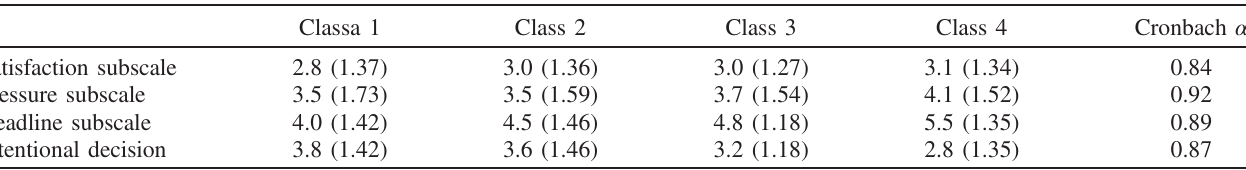
TABLE VI. Mean scores of the procrastination subscales for each of the LPA completion classes. Standard deviations in parenthesis. Level of reliability for each subscale in final column. Scales range from 1 to 7 with 4 being